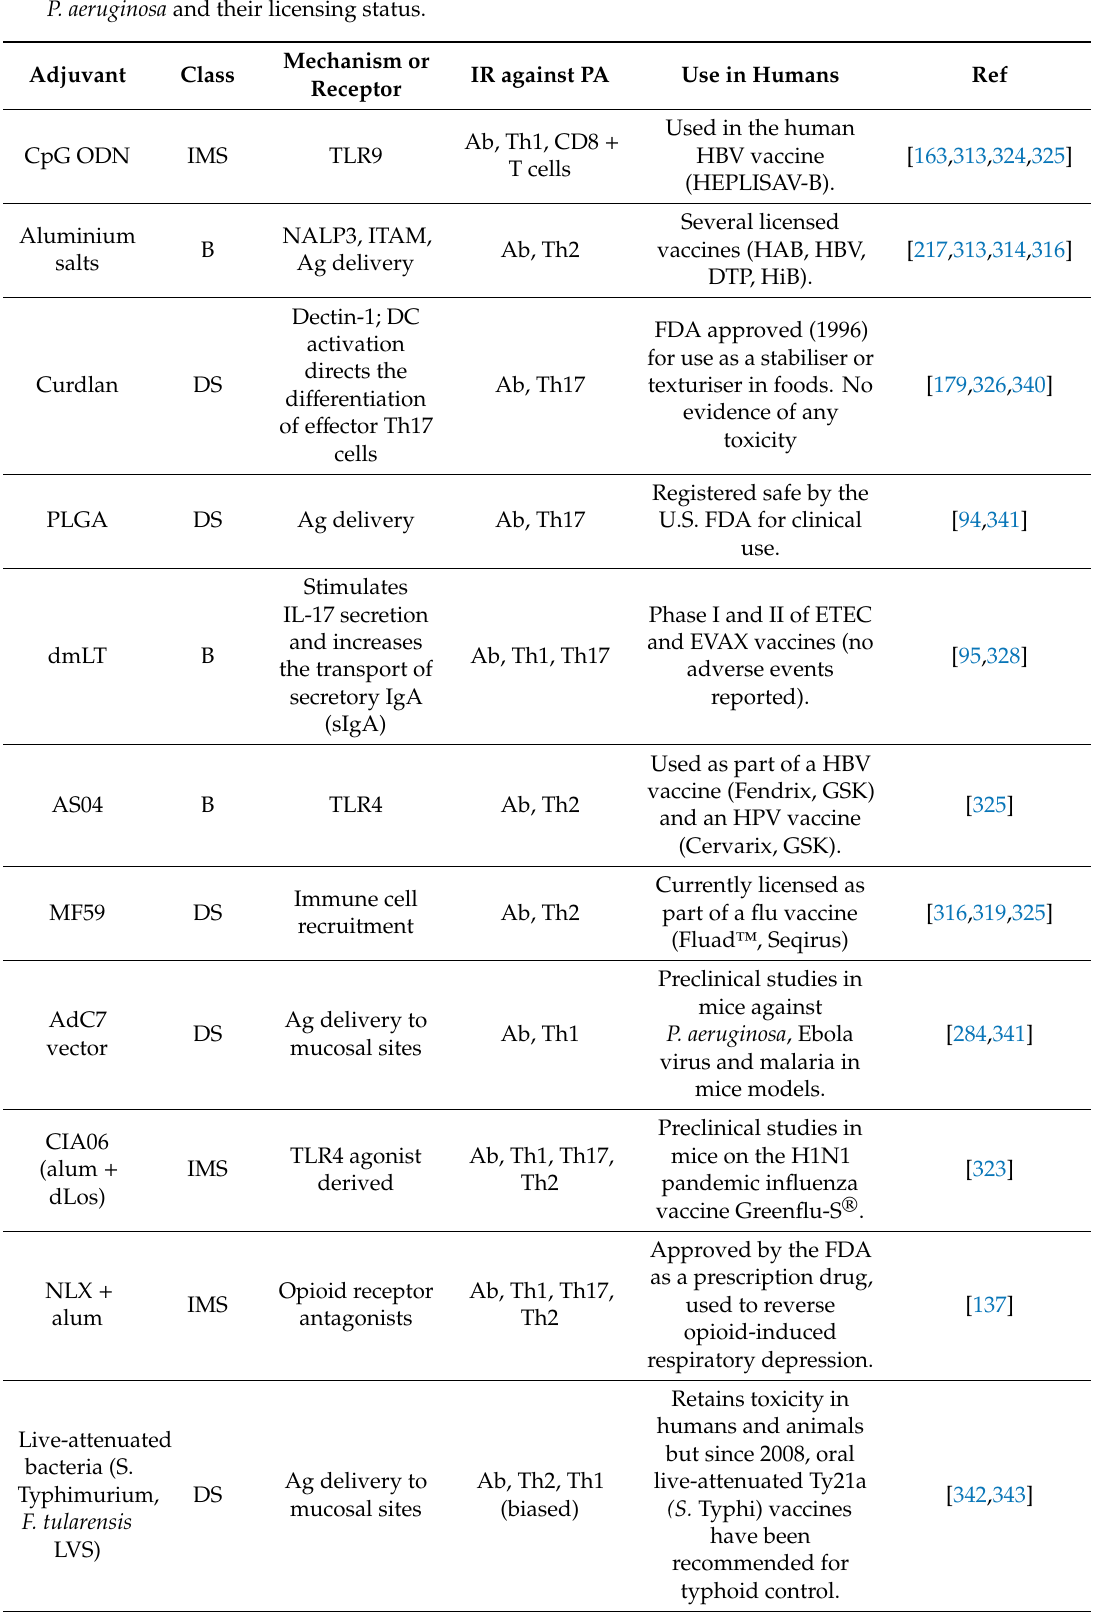
Table 4. Examples of adjuvants used in P. aeruginosa vaccine candidates, the responses achieved against P. aeruginosa and their licensing